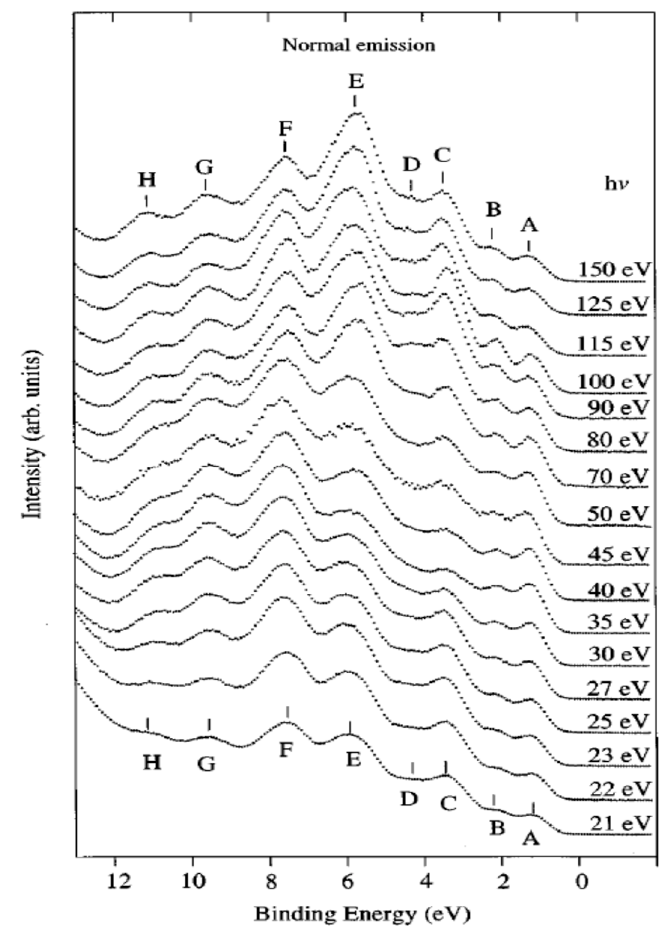
Figure 2. Angle-resolved photoemission spectroscopy (ARPES) photoemission spectra of α -(BEDT-TTF) 2 I 3 obtained in normal emission, with photon energies between 21 and 150 eV. Different structures in the valence band regime are labeled A to H and marked with tick marks in the spectra. The spectra are normalized to the same height. From Ref. [55] with permission.